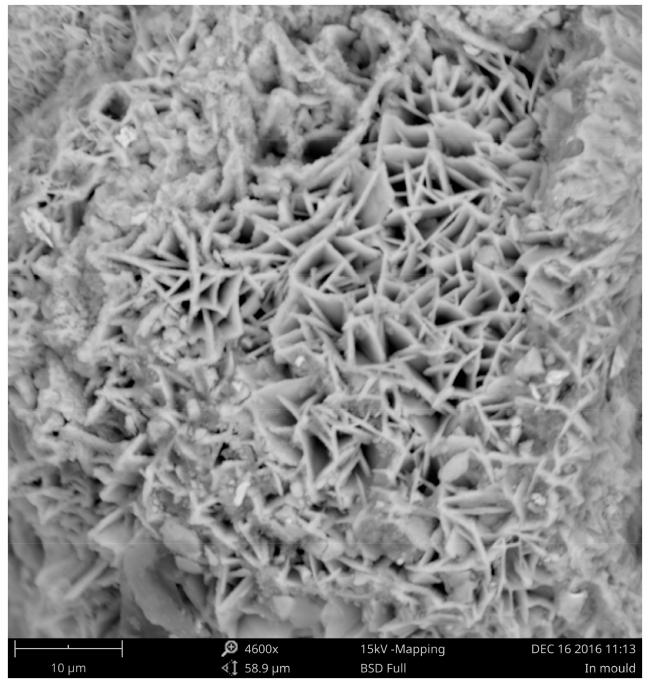
Figure 8. Layer of poorly adhering corrosion products on the surface of the ductile iron casting done using the in-mold